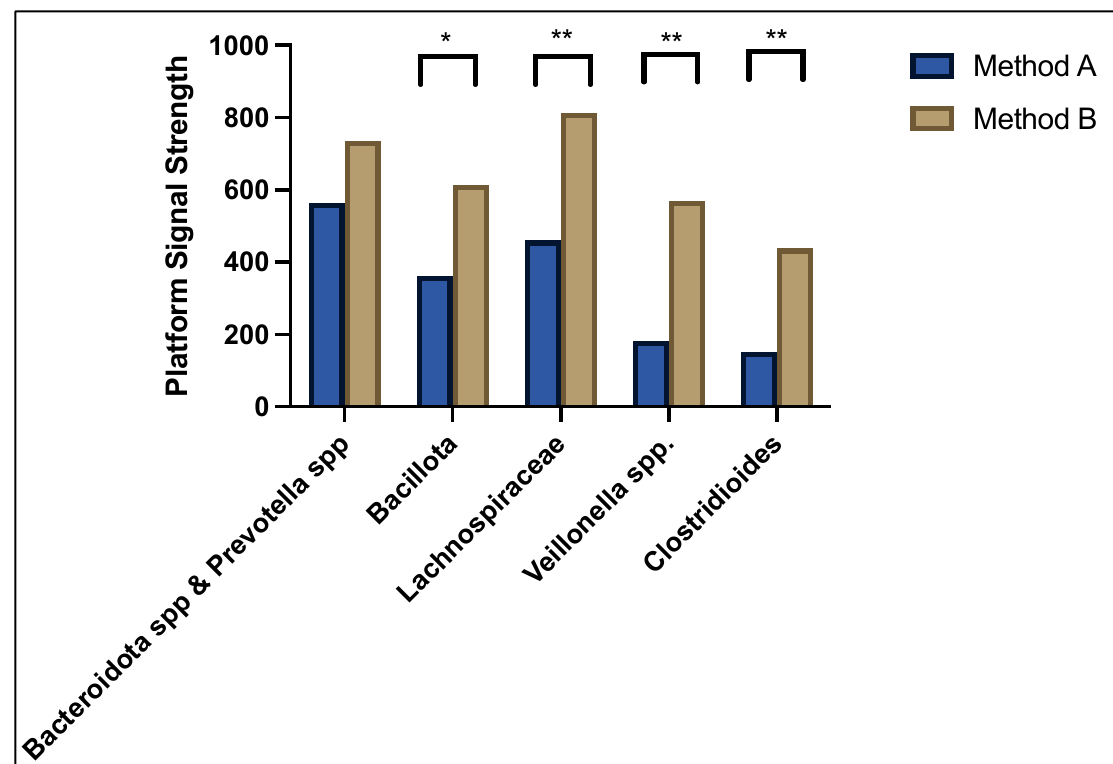
Figure 2. Median signal strength for top five predominant bacteria contributing to dysbiosis. * denotes p < 0.05 and ** denotes p < 0.001.